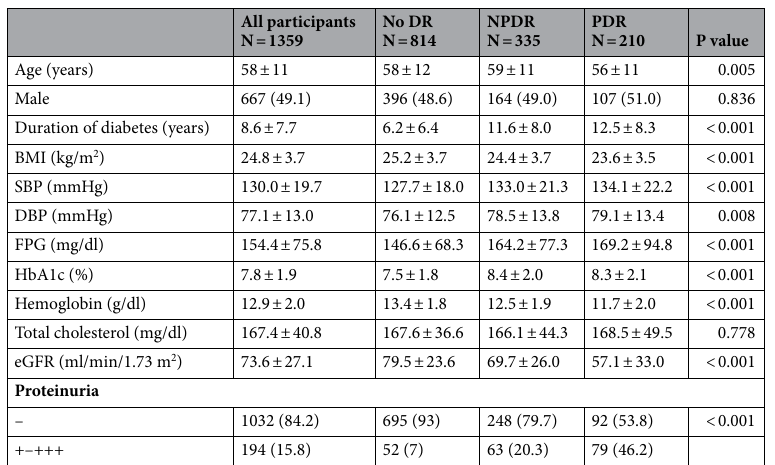
Table 1. Baseline characteristics of the study population according to retinopathy status. Data are expressed as mean ± standard deviation and number (percent). DR, diabetic retinopathy; NPDR, nonproliferative diabetic retinopathy; PDR, proliferative diabetic retinopathy; BMI, body mass index; SBP, systolic blood pressure; DBP, diastolic blood pressure; FPG, fasting plasma glucose; Hemoglobin A1c, HbA1c; eGFR, estimated glomerular filtration rate.